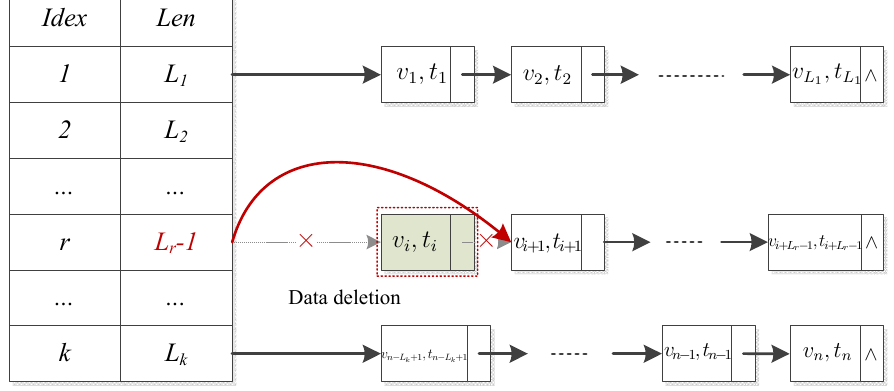
Figure 6. Data block deletion